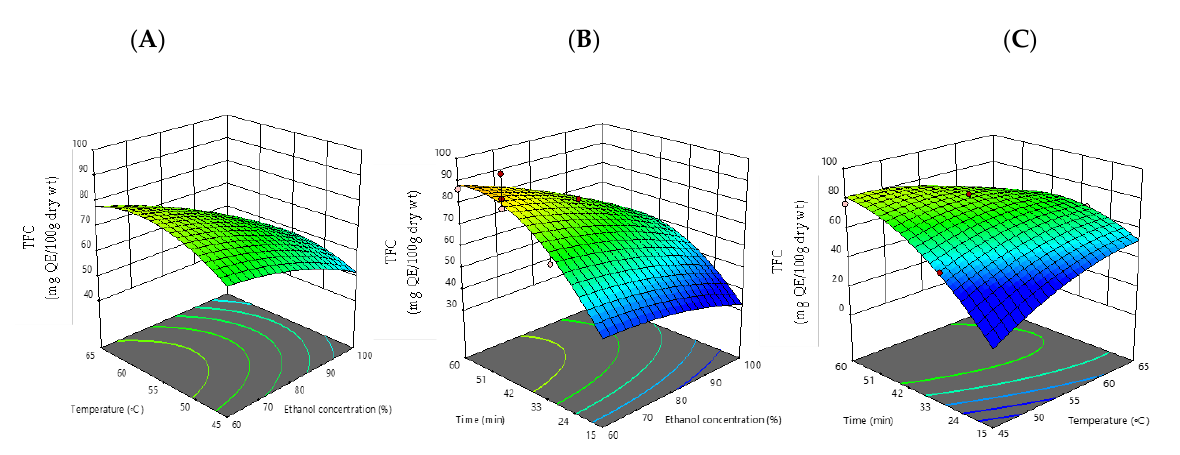
Figure 1. Response surface plots (3D) of total phenolic compound (TPC) as a function of significant interaction between factors; ( A ) temperature and ethanol concentration; ( B ) time and ethanol concentration; ( C ) time and temperature of CSP extract.